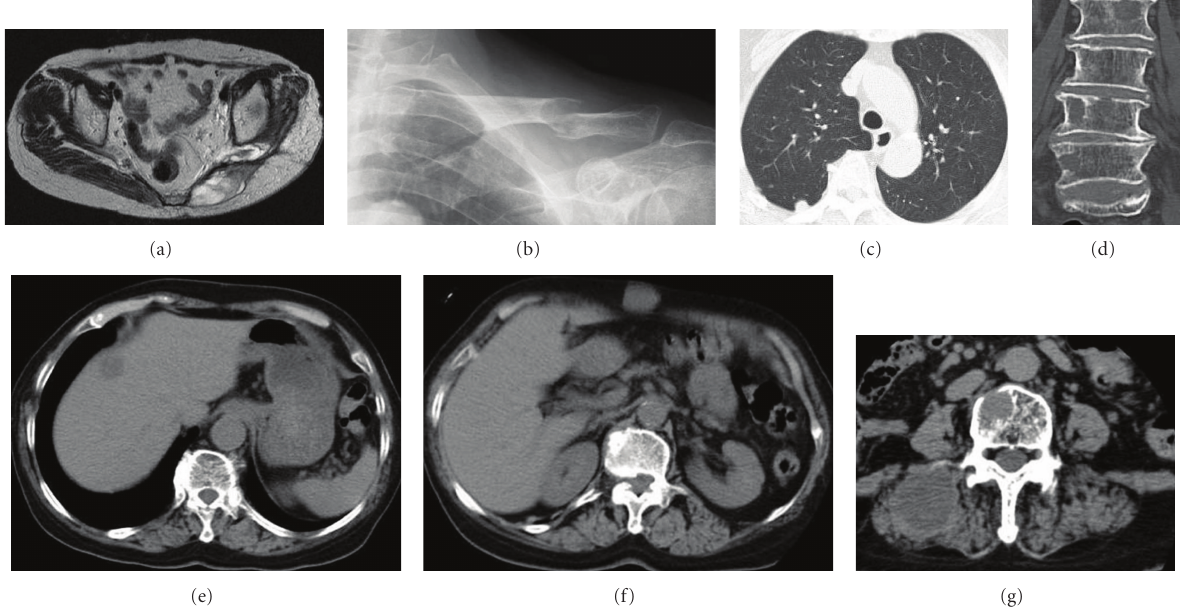
Figure 4: 15 months after the operation, MR images, plain X-ray, and computed tomography demonstrated (a) a local recurrence and multiorgan dissemination including the (b) clavicle, (c) lung, (d) spine, (e) liver, (f) abdomen, and (g) paravertebral